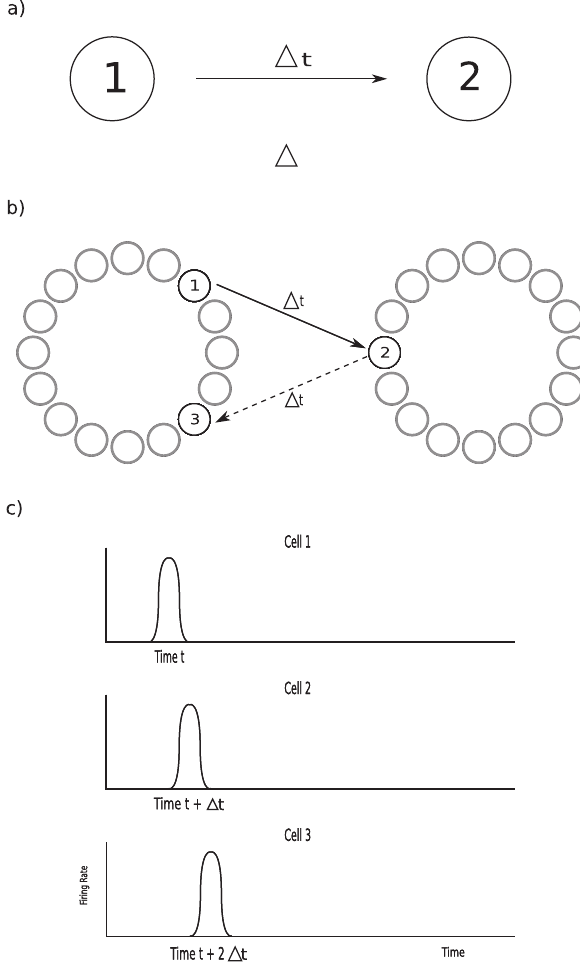
Figure 1. Network architecture for two-layer self-organizing neural network model of the head direction system. The network architecture contains a layer of head direction (HD) cells representing the current head direction of the agent; a layer of combination (COMB) cells representing a combination of head direction and rotational velocity; and a layer of rotational velocity (ROT) cells that become active when the agent rotates. There are four types of synaptic connection in the network, which operate as follows. The w 1 ij